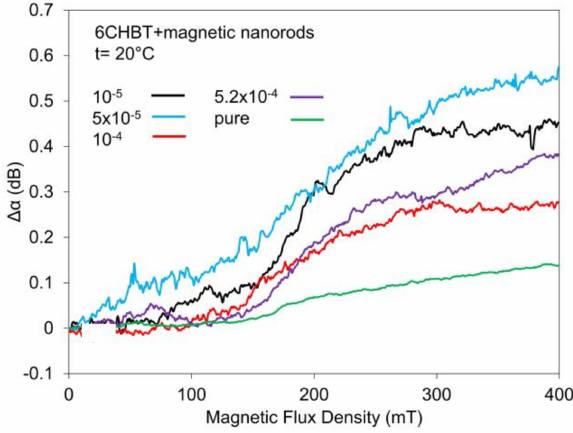
E ff ect of magnetic field on SAW attenuation for 4-(trans-4 (cid:48) -n-hexylcyclohexyl)- isothiocyanatobenzene (6CHBT) doped with nanorods of di ff erent concentrations, including pure